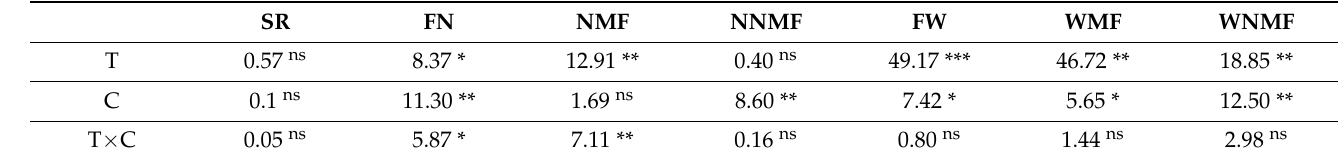
Means are ± SE, different lowercase letter within the same line indicate significant ( p ≤ 0.05) difference between cultivars, different uppercase letter within the same line indicate significant difference between treatments according to LSD test. Table 7. Analysis of variance for the effect of cultivar (C), treatment (T) and their interactions on tomato yield attributes.